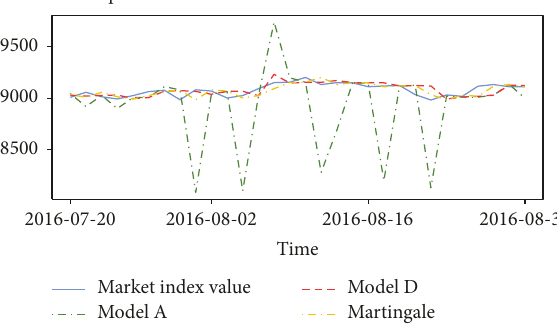
Figure 19: Time plots of raw data and the forecasts of model A, D and the